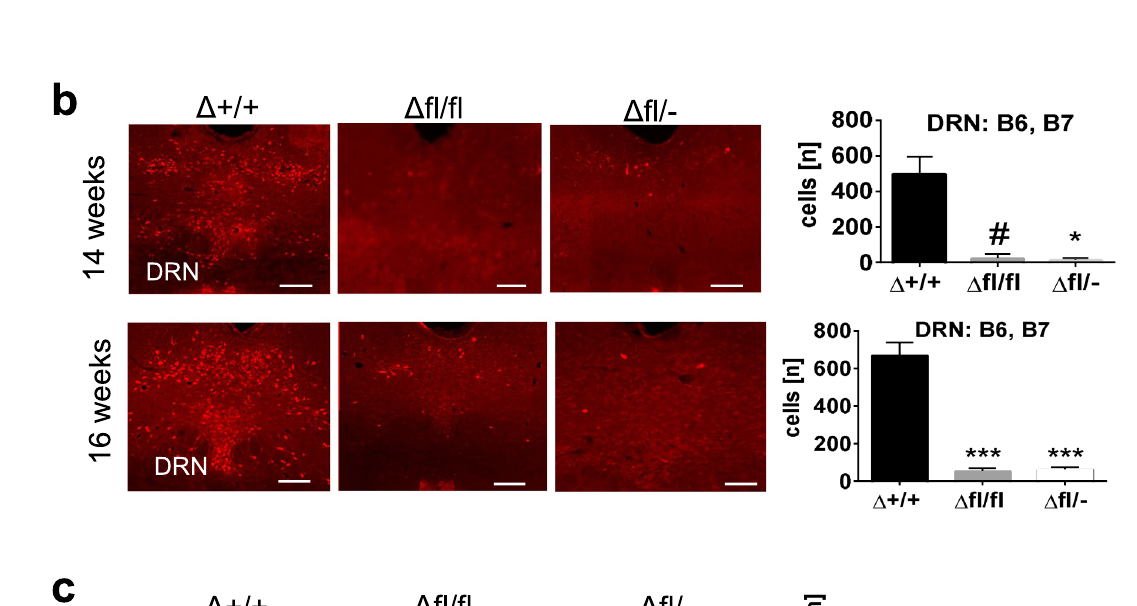
2, Tph2 Δ+ l + displayed significantly higher concentrations of 5-HIAA than Tph2 Δ fl / fl and Tph2 Δfl /− (both p < 0.0001) like in the brainstem, which was also detected in week 4 [ Tph2 Δ fl / fl ( p = 0.0767); Tph2 Δfl /− ( p = 0.0258)] and week 6 [ Tph2 Δ fl / fl ( p = 0.0683); Tph2 Δfl /− ( p = 0.0285)] also less pronounced. In the amygdala a significant genotype × time interaction effect was observed (F (4,40) = 9.316; p < 0.0001; Fig. 2a, right panel). Similar to the other brain regions, 5-HT concentrations in Tph2 Δ +/+ was significantly lower com- pared to Tph2 Δ fl / fl ( p = 0.0023) and Tph2 Δfl /− ( p = 0.0214) at week two after induction and increased towards week 6 resulting in higher concentrations of 5-HT than Tph2 Δ fl / fl ( p = 0.0004) and Tph2 Δfl /− ( p = 0.0044). However, no